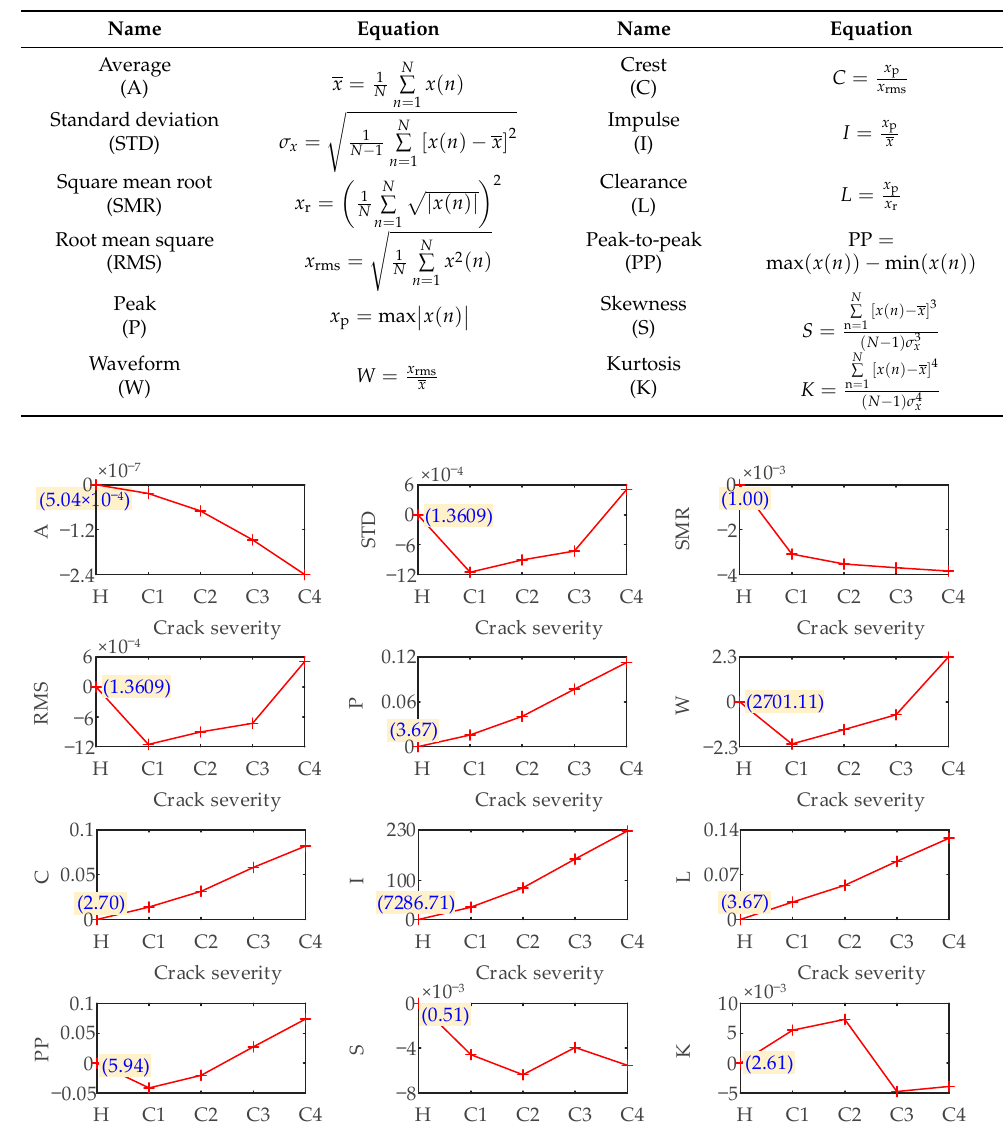
Table 5. Time-domain statistical indicators.